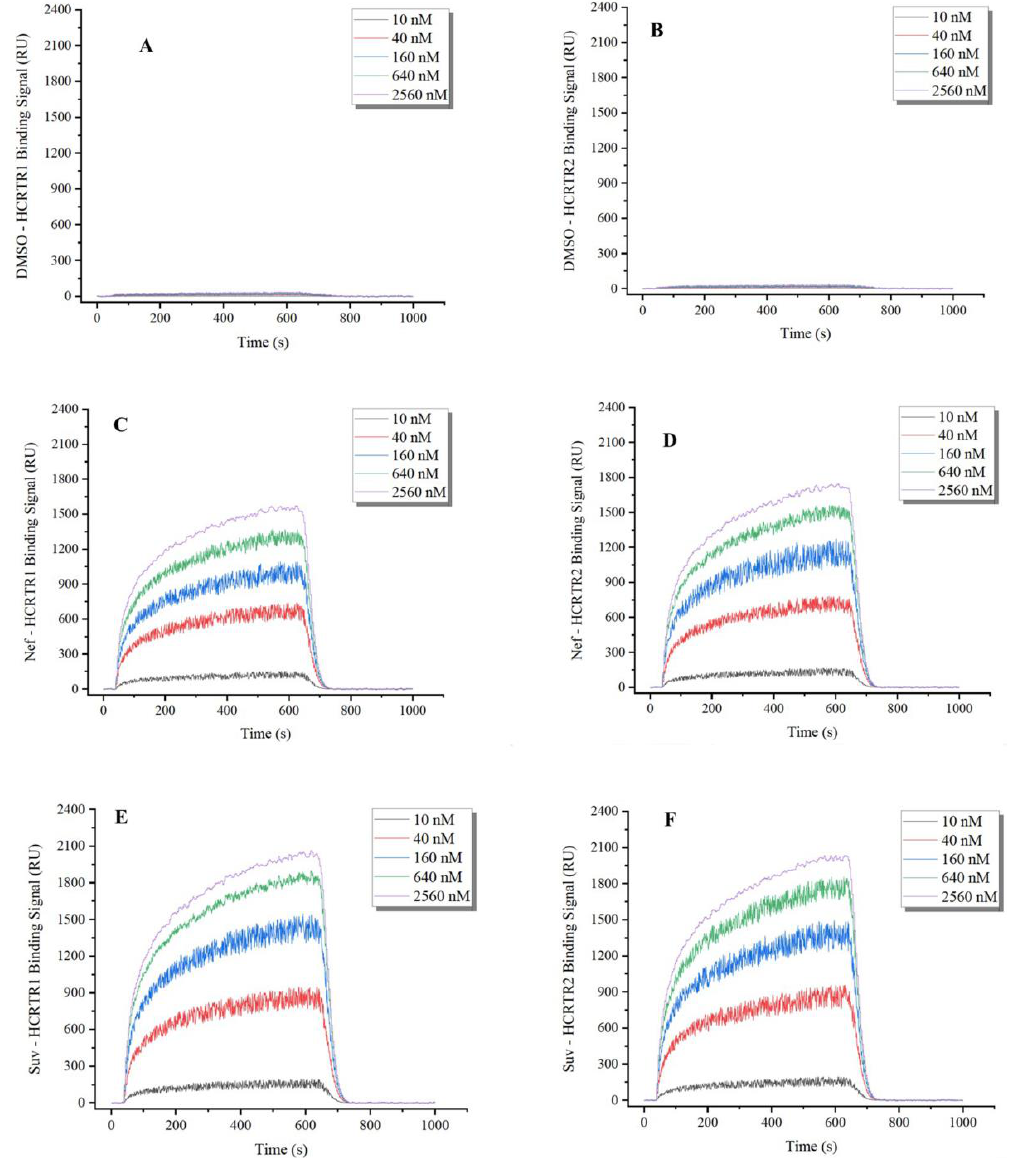
Figure 2. The binding kinetics between orexin receptors and ligands using SPR analysis. (Dynamic binding curves of DMSO ( A ), neferine ( C ), and suvorexant ( E ) interaction with different concentrations of orexin 1 receptor at the resonance wavelength. Dynamic binding curves of DMSO ( B ), neferine ( D ), and suvorexant ( F ) interaction with different concentrations of orexin 2 receptor at the resonance wavelength.)